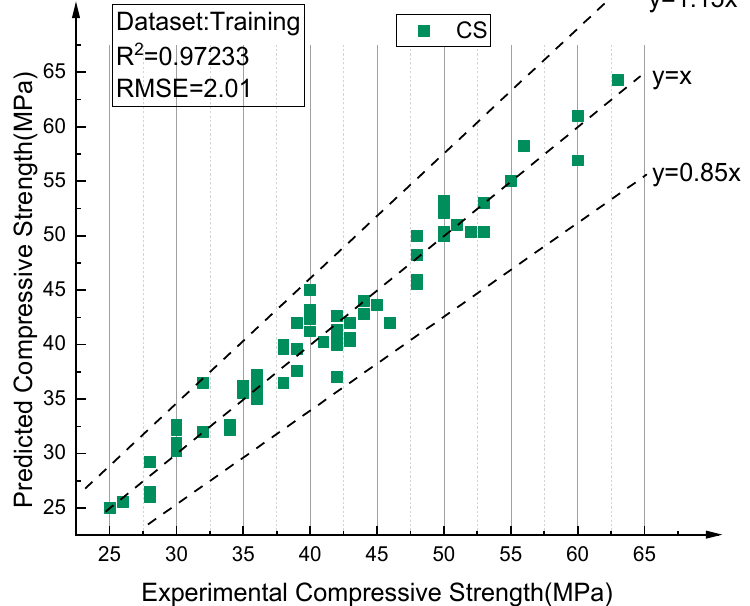
Figure 25. Comparison between prediction values and test values of RAC compressive strength (training data).